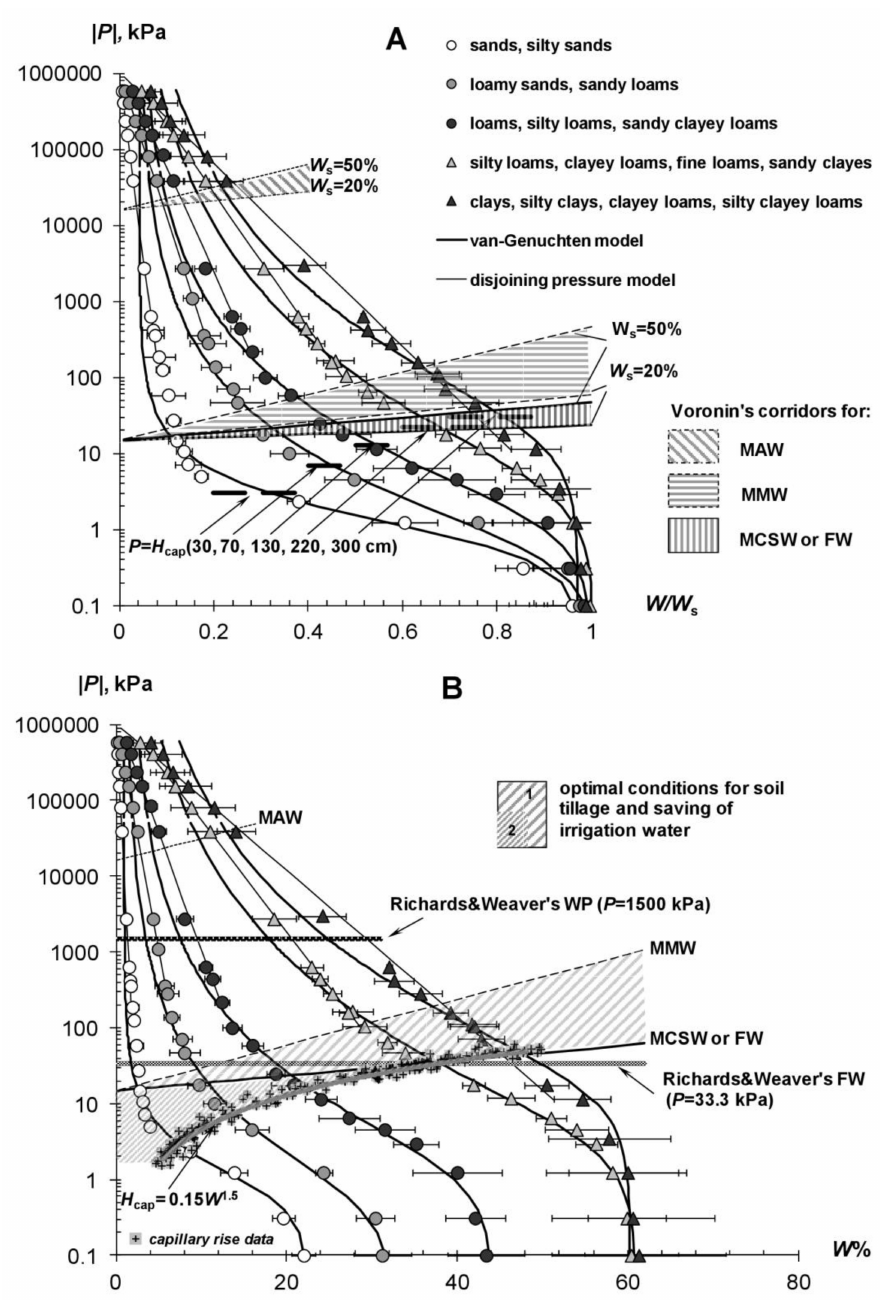
Figure 4. Diagrams of the physical quality of Eurasian soils of different genesis and dispersity from the author’s WRC database. ( A ) Scaling by using the maximum water content in the saturated state of the soil ( W / W s ), ( B ) evolvent of the scaling diagram using typical values of W s = 23, 32, 44, 61, 62%; horizontal bars are confidence intervals at p <